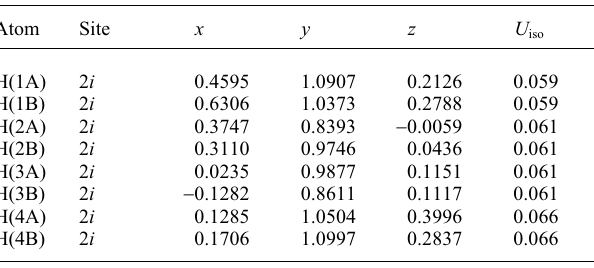
Table 3. Atomic coordinates and displacement parameters (in Å 2 ) .